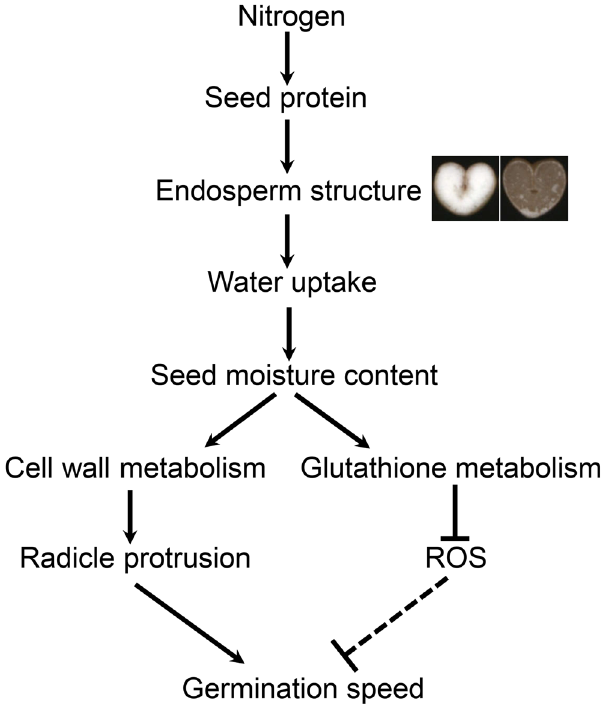
Figure 6. A hypothetical model for nitrogen affecting seed germination speed in wheat. Solid lines indicate the direct or definite regulation; dotted lines indicate the indirect or undetermined